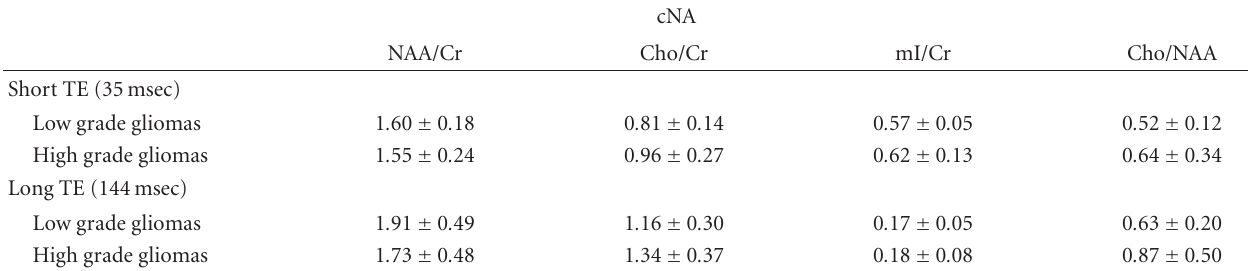
Table 2: Mean values and standard deviation of cNA metabolic ratios for short TE (TE = 35msec) and long TE (144 msec). cNA NAA/Cr Cho/Cr mI/Cr